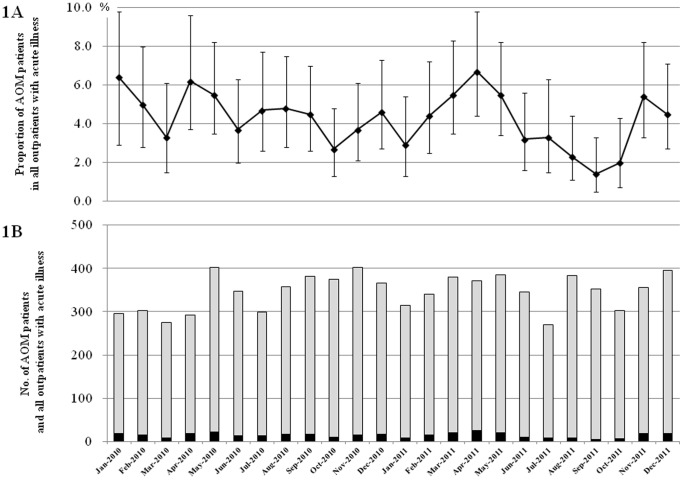
Pediatric patients with acute otitis media in Sado Island by surveillance week 1A.The proportion of acute otitis media patients with 95% CI among all outpatients showing acute illness. 1B. The black bar and gray bar indicate the number of acute otitis media patients and all outpatients with acute illness, respectively. AOM, acute otitis media.